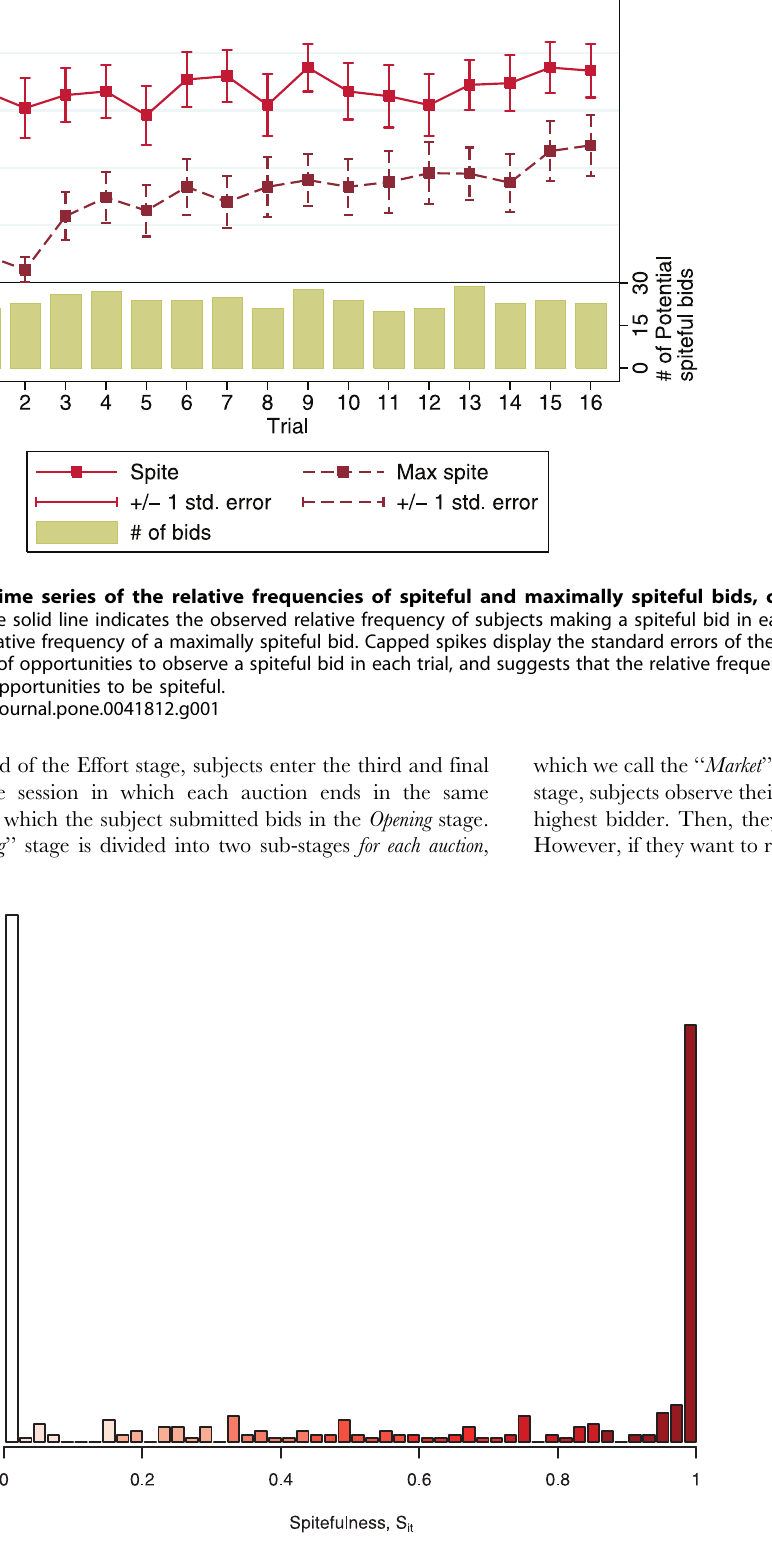
Figure 2. Histogram of measured spitefulness ( S i , t ), pooled over all subjects and trials. The height of each bar represents the relative frequency of observing spitefulness in each of 50 intervals of length 0.02. Nearly 70% of the weight of the distribution is in the extreme values zero and one, indicating that, given the opportunity, subjects are either maximally spiteful or not spiteful at all.